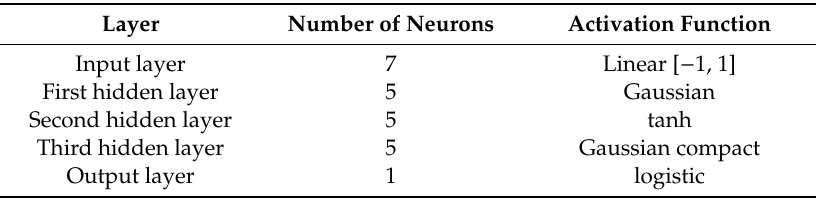
Table 6. Characteristics of the selected neural